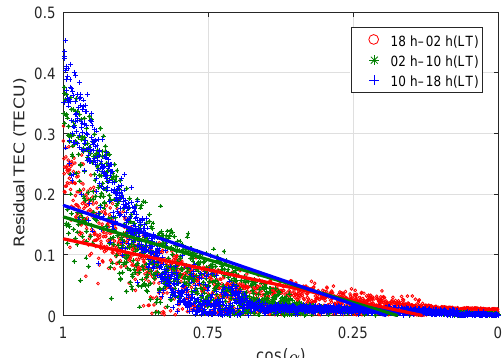
Figure 5. Residual TEC along the signal path with tangent point at 0–30 ◦ (blue), 30–60 ◦ (green) and 60–90 ◦ (red) in the Southern Hemisphere (a) and in the Northern Hemisphere (b) . The x axis is the absolute cosine value of the RO azimuth, and the y axis is the absolute value of residual TEC.